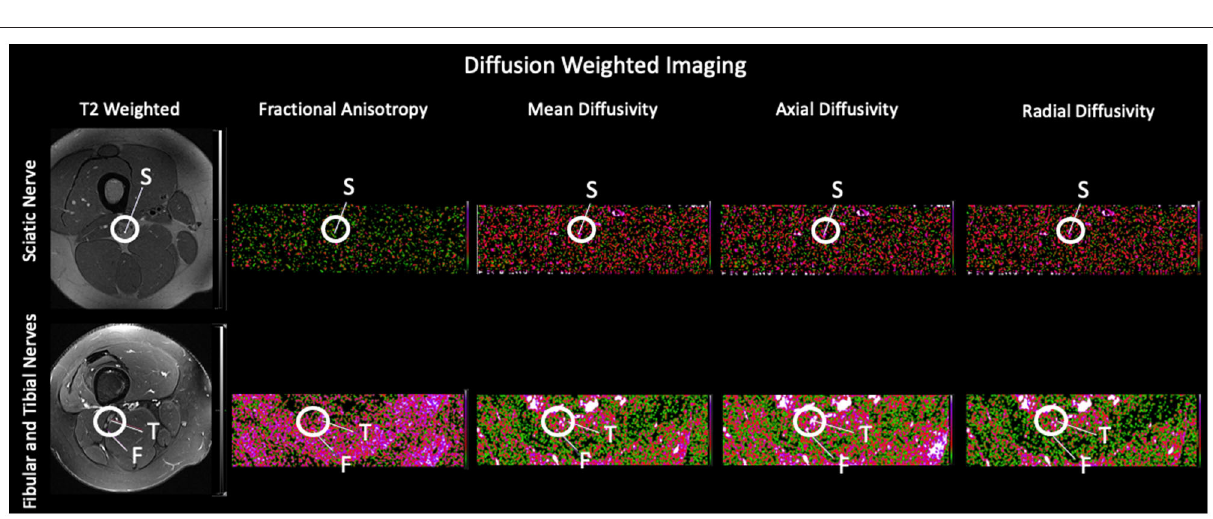
FIGURE 2 | Regions of Interest using Diffusion Tensor Imaging and Magnetization Transfer Ratio Imaging. Exemplar slices from a healthy control are used to show each of the evaluated nerve divisions on the representative T2 weighted scan and their corresponding diffusion weighted scan and using Magnetization Transfer Ratio Imaging. S, Sciatic Nerve; F, Fibular Nerve; T, Tibial